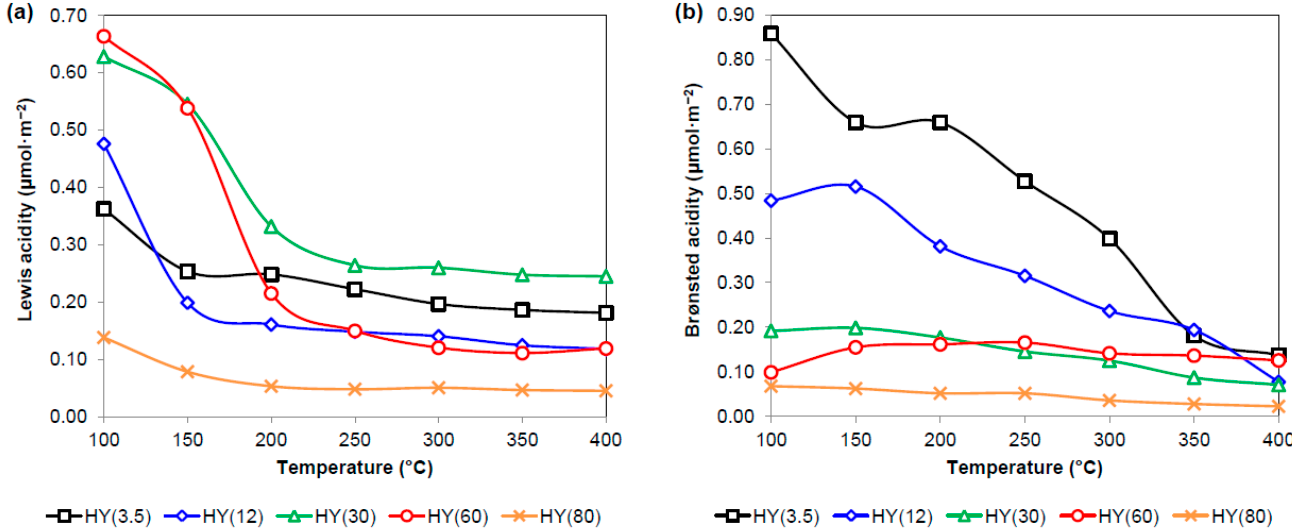
Figure 5. Quantification of ( a ) Lewis and ( b ) Brønsted acid sites of the HY zeolites at different temperatures.